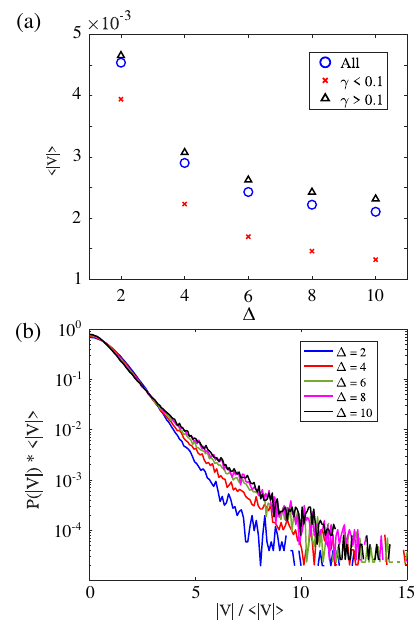
Figure 4. (a) Mean absolute vorticity (cid:104)| V |(cid:105) as a function of step size ∆ . (b) Probability distribution function of the absolute vor- ticity | V | . Data in both (a) and (b) are from all strain steps at the lowest packing fraction φ = 0 .